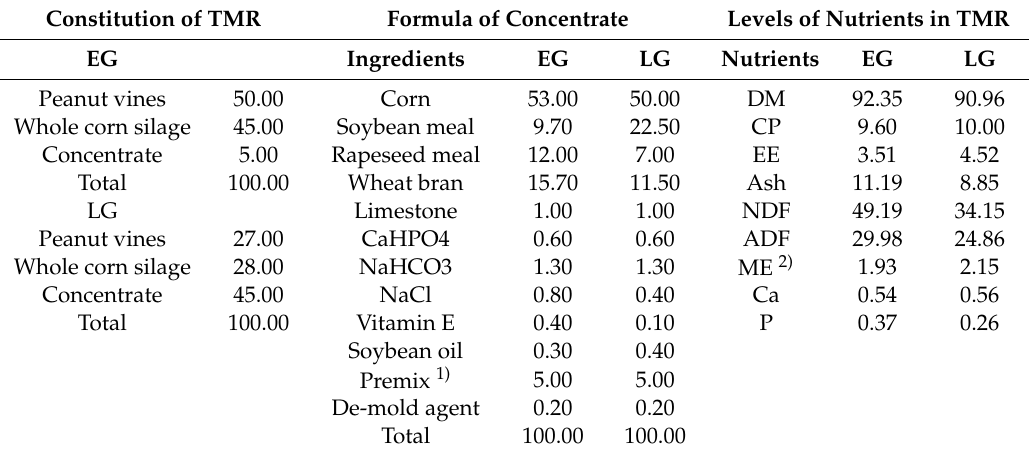
Table 1. The composition and nutrient levels in the basal total mixed ration (TMR) (dry-matter basis, %). Constitution of TMR Formula of